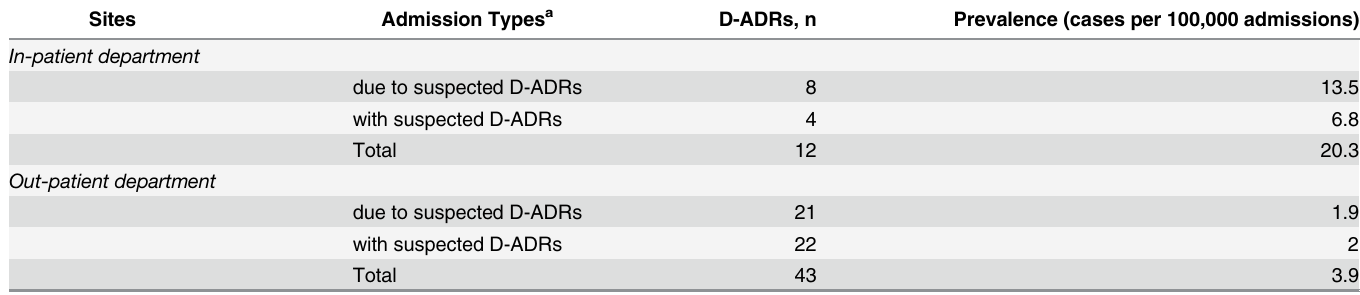
Table 2. The prevalence of spontaneous reports of suspected D-ADRs related admissions during the study